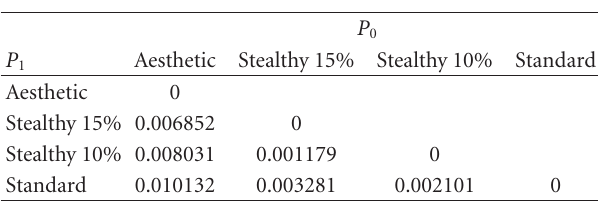
Table 2: G ( P 1 | P 0